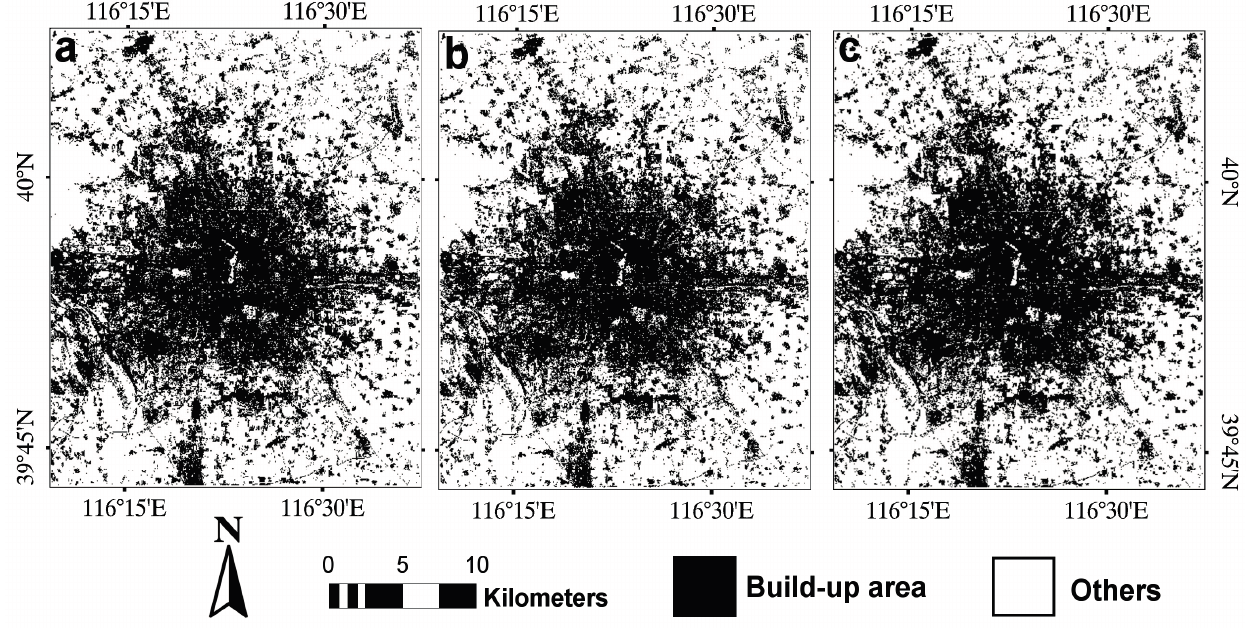
Figure 4. Classification results of the 1995 Beijing image using spectral information alone ( a ); using spectral information and one-band texture ( b ); and using spectral information and multivariate texture with spectral angle distance ( c ).